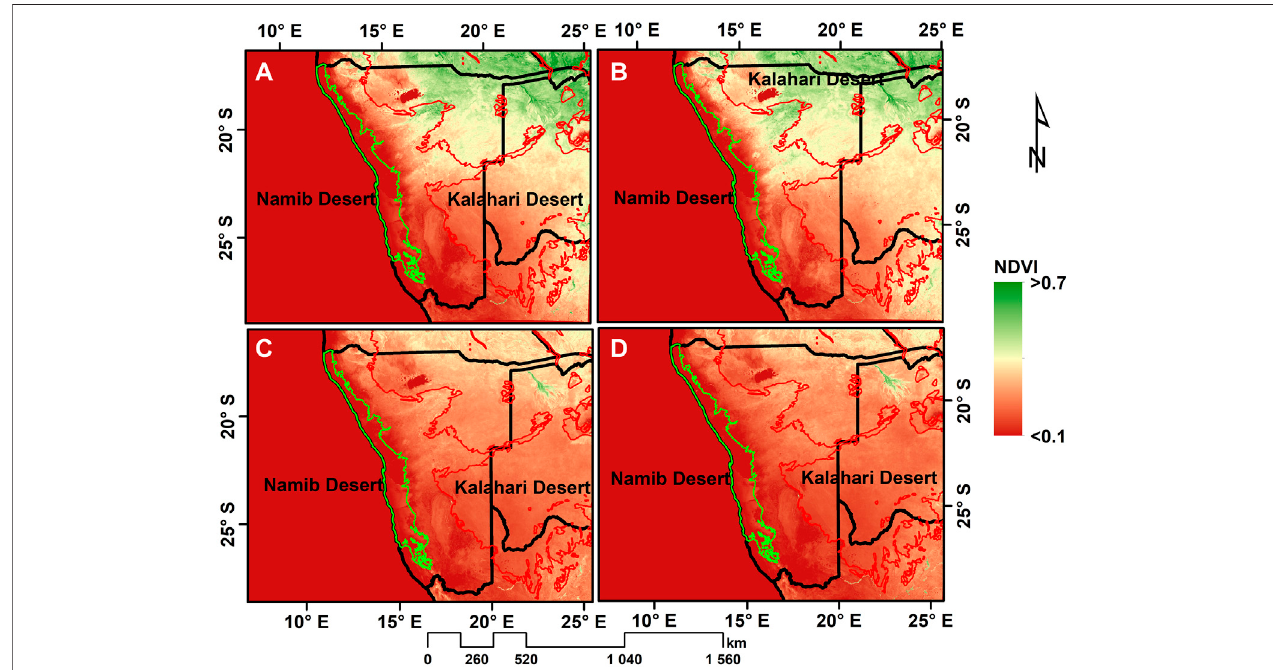
FIGURE 7 | Seasonal NDVI map distribution in (A) DJF, (B) MAM, (C) JJA and (D) SON seasons, obtained from MODIS MOD13Q1 product.